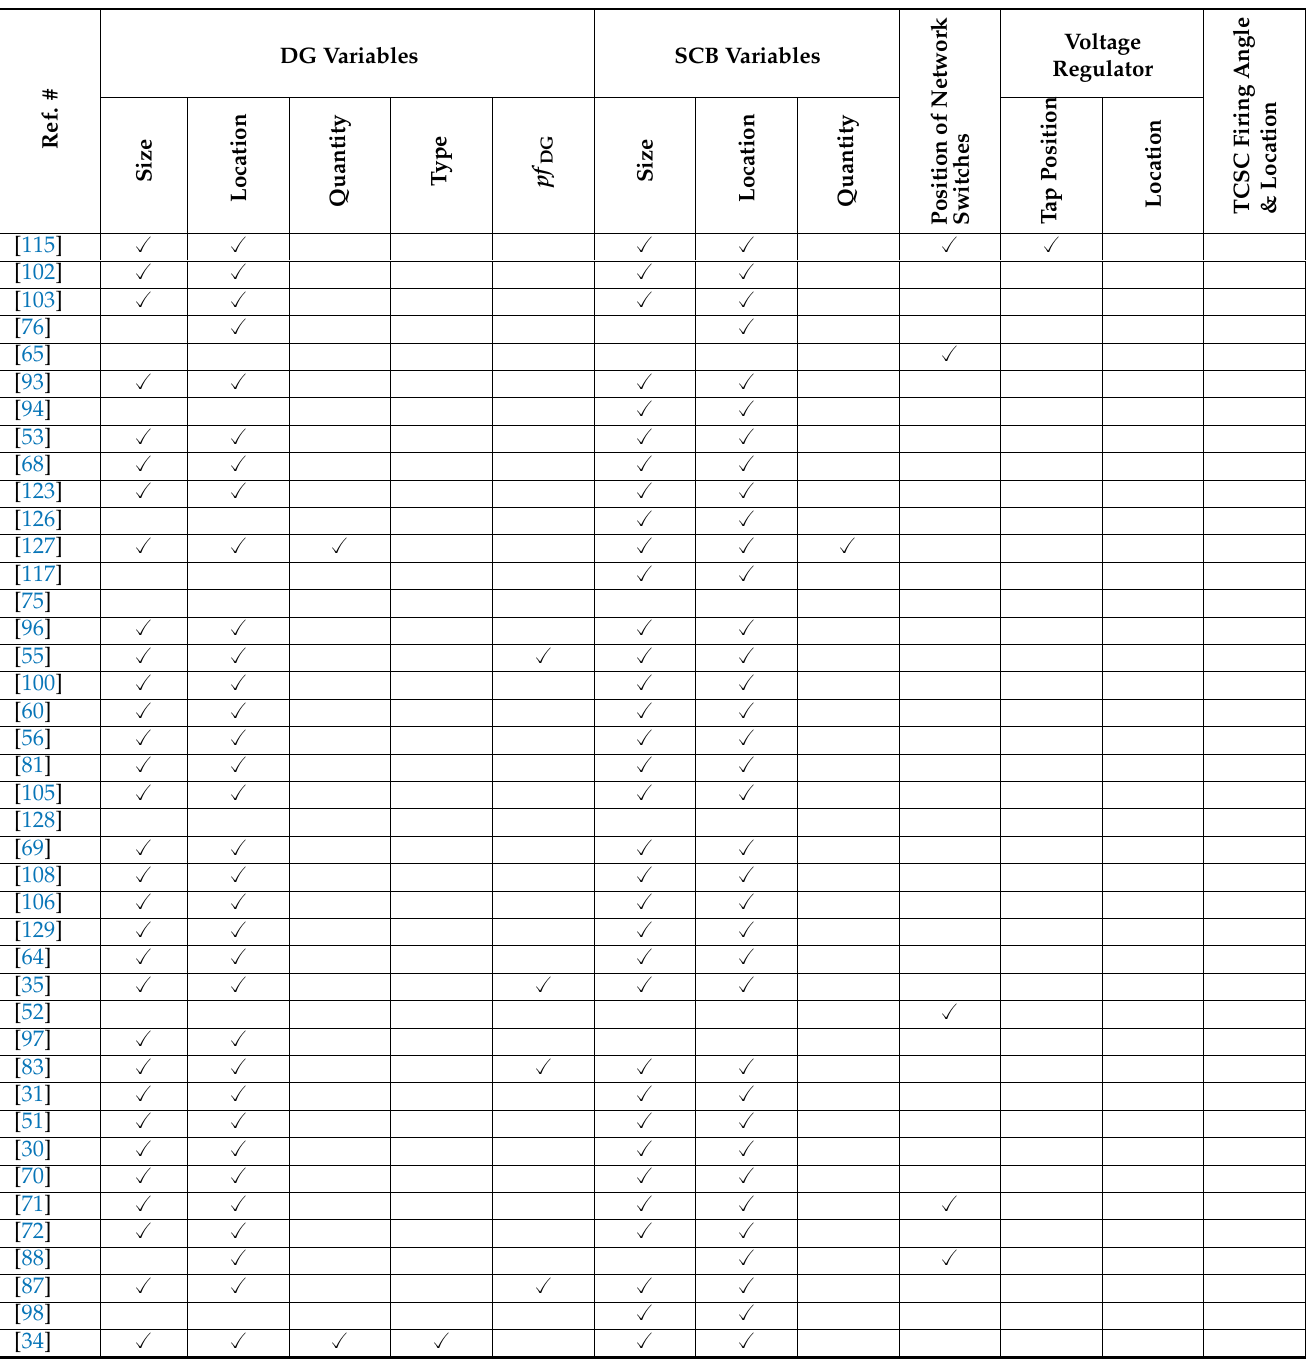
Table 4. Decision variables employed for optimal DG and SCB